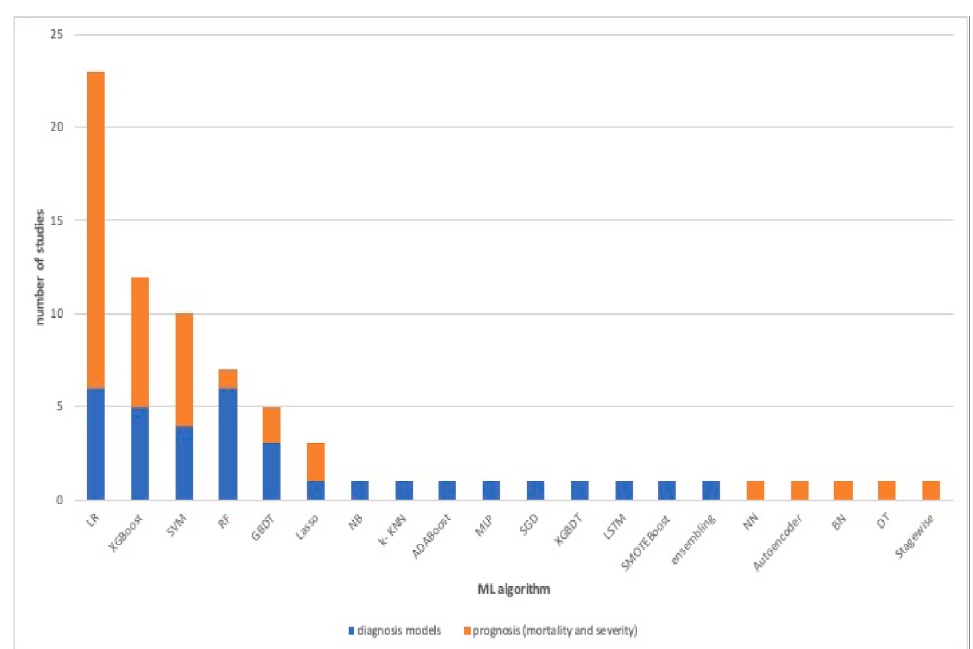
Figure 6. The machine and statistical models used for COVID-19 diagnosis and prognosis adapted from